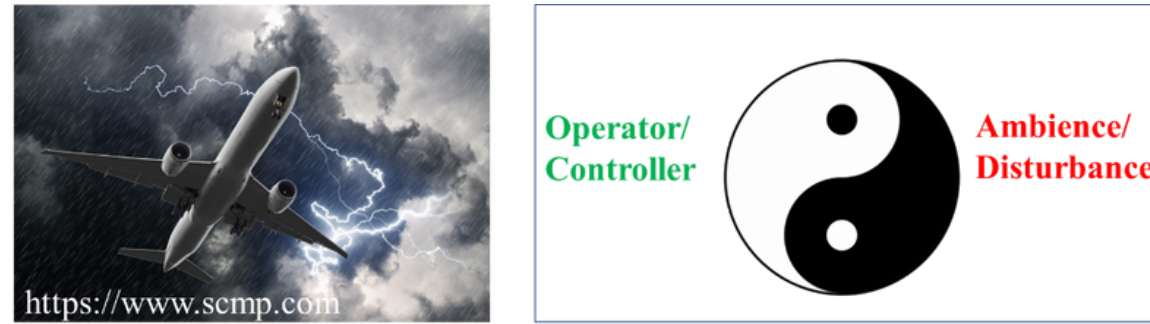
Figure 1. Flying an airplane through a turbulent ambience (left panel) and the coexistence of knowns and unknowns in a system via the Yin-Yang symbol (right